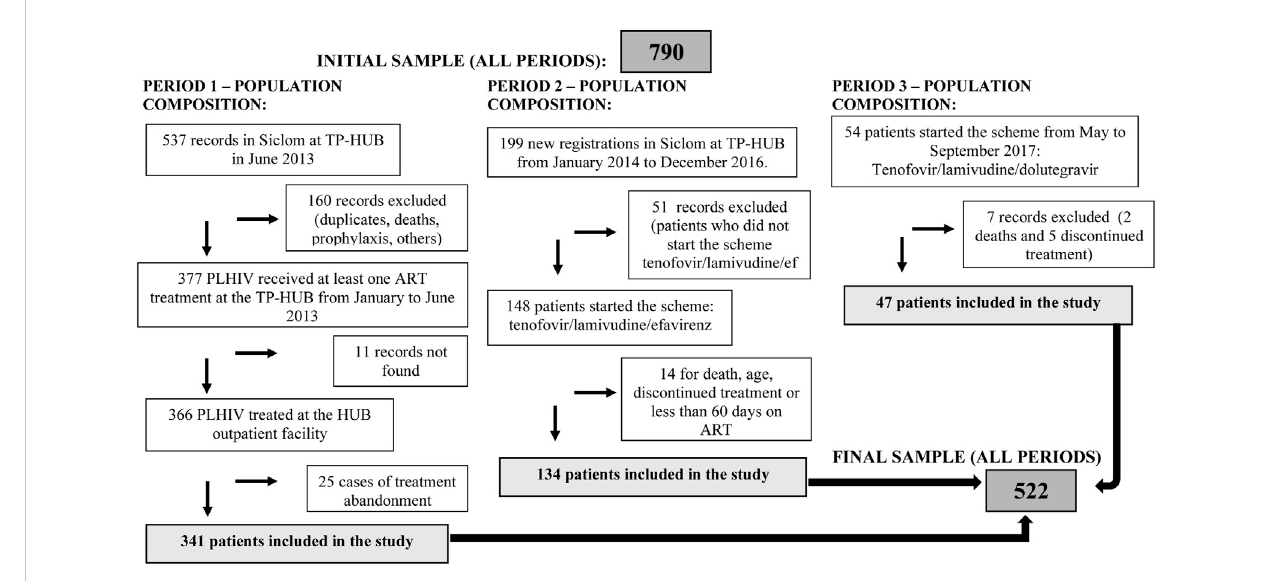
FIGURE 1 Flowchart with the composition of the sample in each study period. Hospital Universitário de Brasilia, Brasilia, Brazil, 2019.